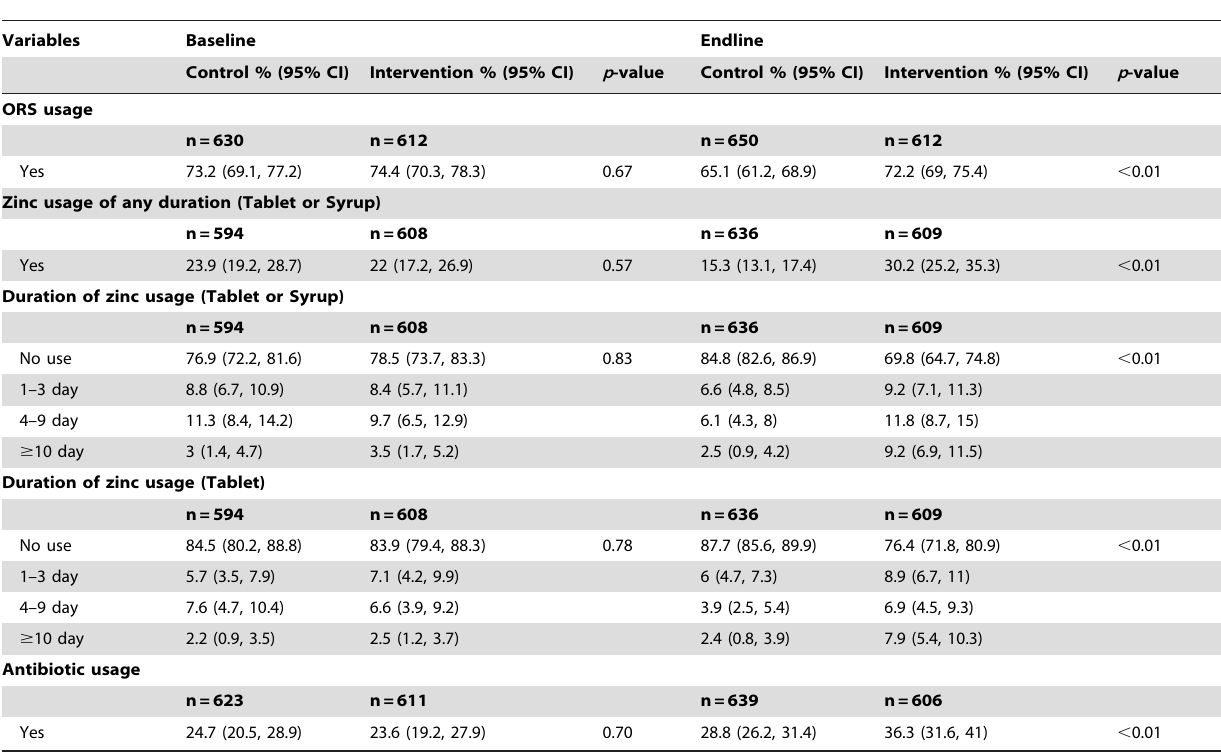
Table 3. ORS, zinc and antibiotic usage in Control and Intervention